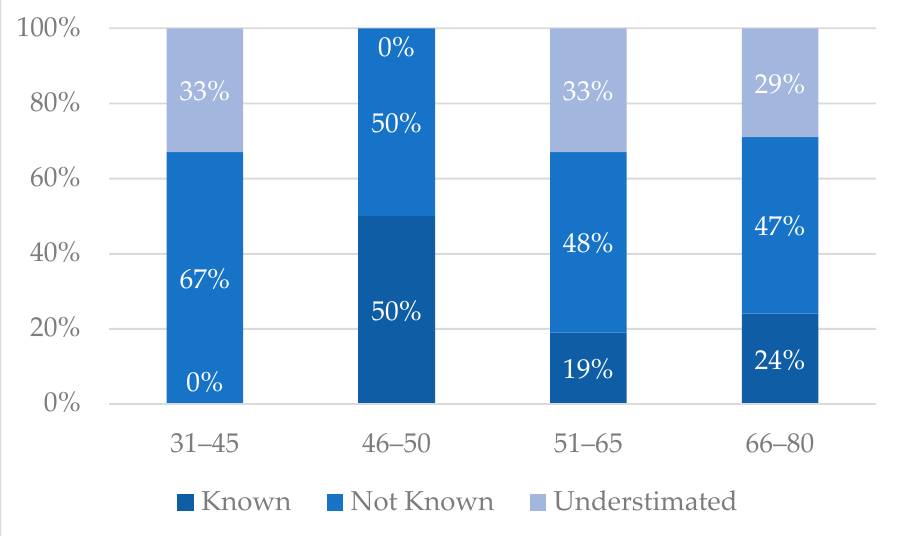
Figure 5. Most feared complications of diabetes. Table 4. Awareness of diabetes complications. Didn’t know